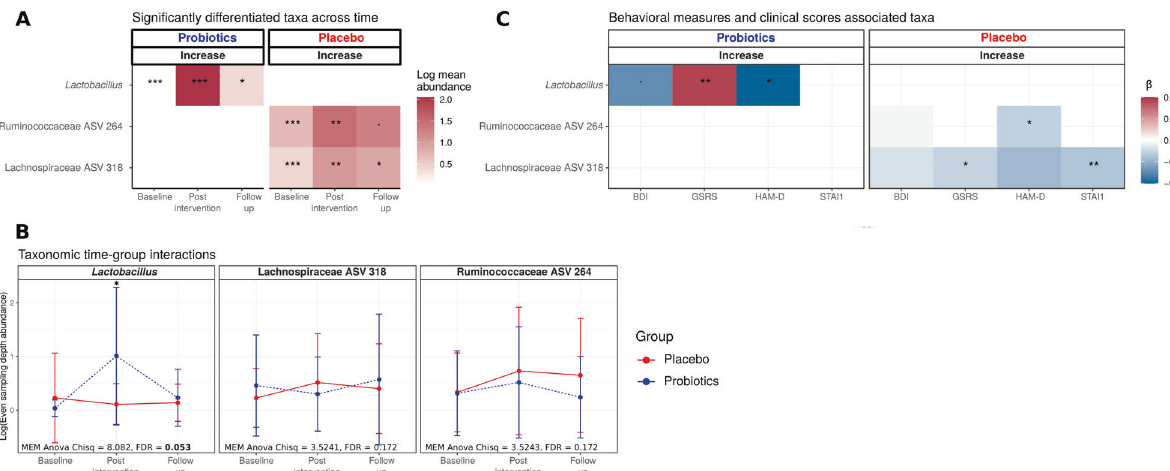
Fig. 4 Signi fi cantly associated taxa to time and behavioral measures. ( A ) Mean abundance of the taxa showing a signi fi cant increase over the study intervention in the placebo and probiotic group, respectively (MEM ANOVA p-FDR < 0.05 and Wald test p -FDR < 0.05). (cid:129) <0.1, *<.05, **<0.01, * * *<0.001 p -FDR values after being adjusted for fecal moisture, sex, BMI, and age. Increases are indicated in relation to baseline values. ( B ) Line plots of the taxa-abundance of those taxa whose abundance differed signi fi cantly over time in the two study groups. The bottom of the panel shows ANOVA results for the time*group interaction, * p < .05 Wald test adjusted. ( C ) Mixed-effect β coef fi cients of the signi fi cantly associated taxa with the clinical measures (HAM-D, BDI, GSRS, STAI1) over time. The signi fi cance of the taxa was determined by using a negative binomial mixed-effect model; (cid:129) <0.1, *<0.05, **<0.01 ANOVA adjusted p-values after being adjusted for fecal moisture, sex, BMI, and age. The gradient color indicates the negative binomial mixed-effect model coef fi cient. HAM-D = Hamilton Rating Scale for Depression; BDI =